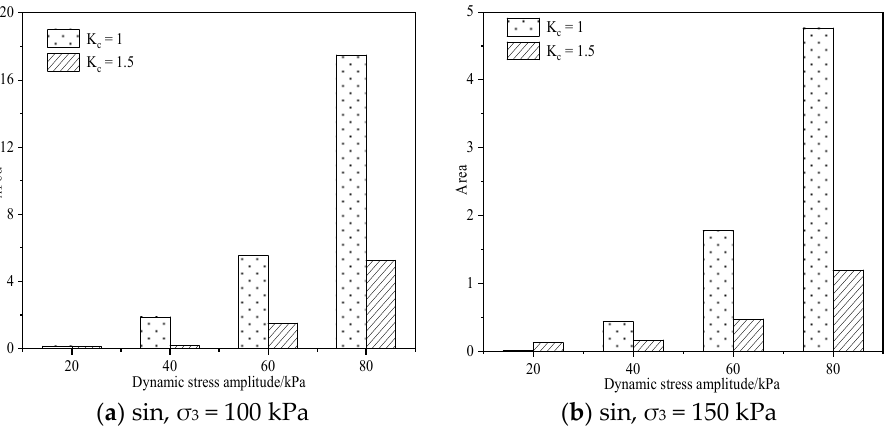
Figure 10. Effect of consolidation ratio on surrounding area of hysteretic curve.